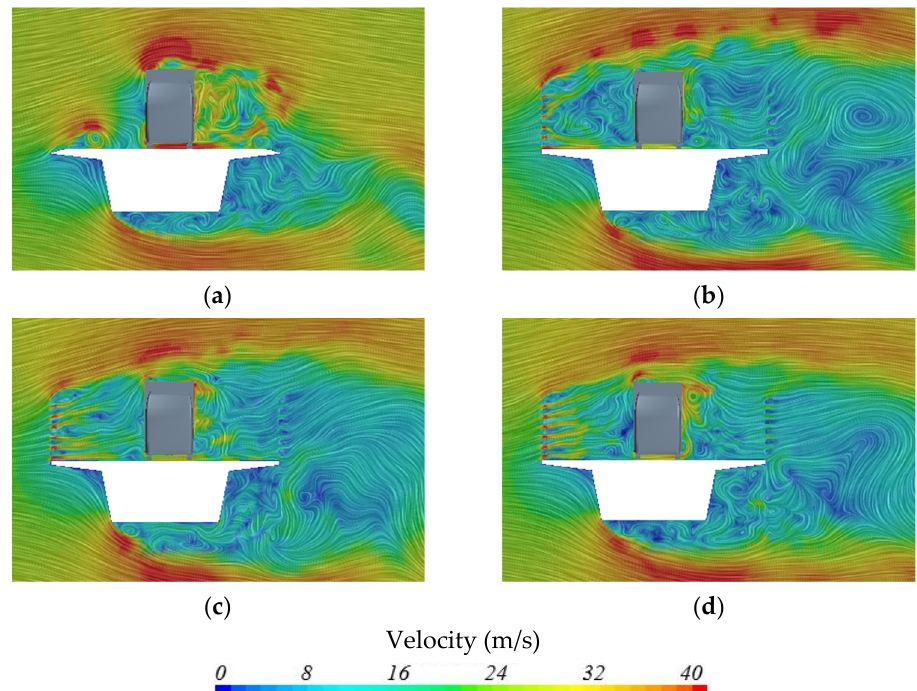
Figure 7. Velocity distribution for different porosity schemes (( a ) Bare bridge; ( b ) Scheme 1; ( c ) Scheme 2-1; ( d ) Scheme 3).